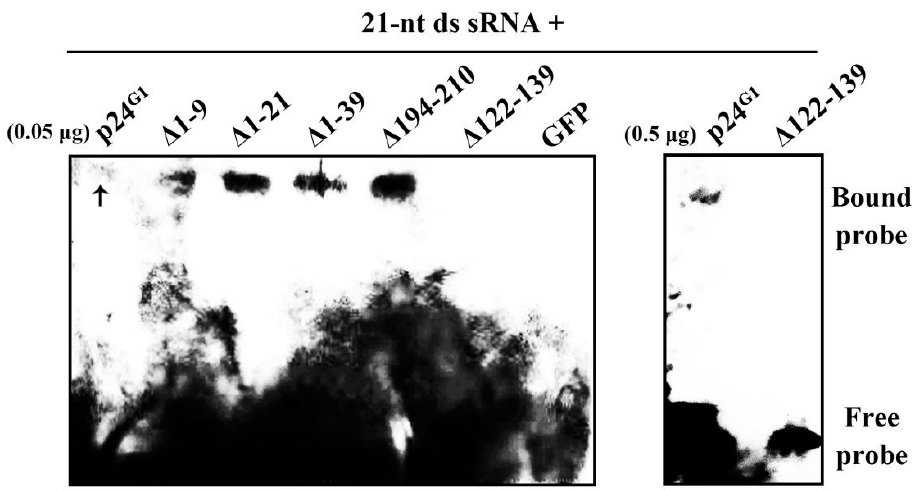
Figure 5. EMSA of the binding of p24 of grapevine leafroll-associated virus 1 (p24 G1 ) and mutants to 21-nt sRNA duplexes. A constant amount (10 ng) of biotin-labeled 21-nt sRNAs was incubated with 0.05 or 0.5 µg of the indicated protein with his-tagged. GFP – His served as the negative control. Arrow indicates the p24 G1 – sRNA complex.